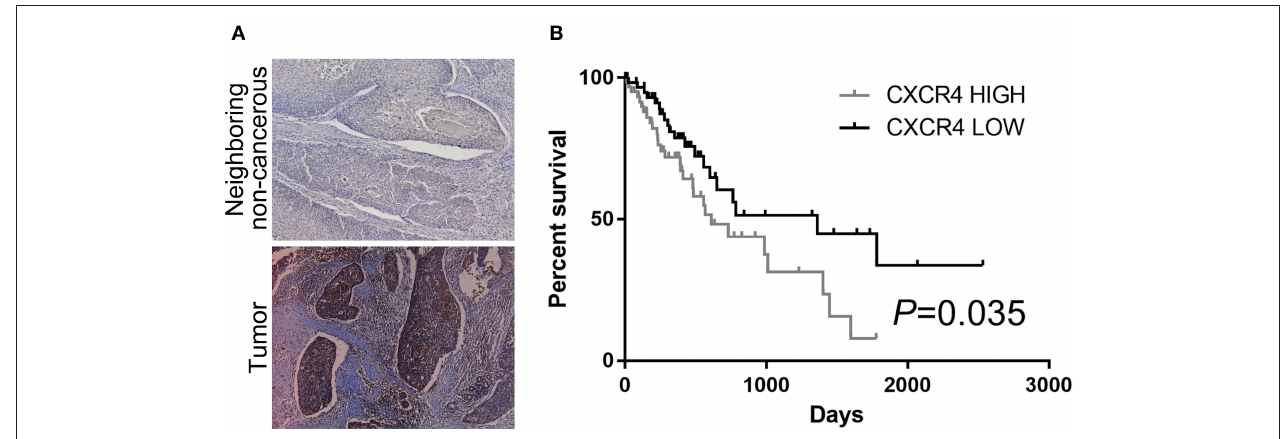
FIGURE 2 | Kaplan-Meier survival analysis in patients with ESCC. (A) Representative immunohistochemical staining of CXCR4 expression in ESCC tissues and their corresponding non-cancerous tissues (magnification, × 100). (B) Kaplan-Meier analysis indicating the correlation of CXCR4 overexpression with poorer overall survival of ESCC